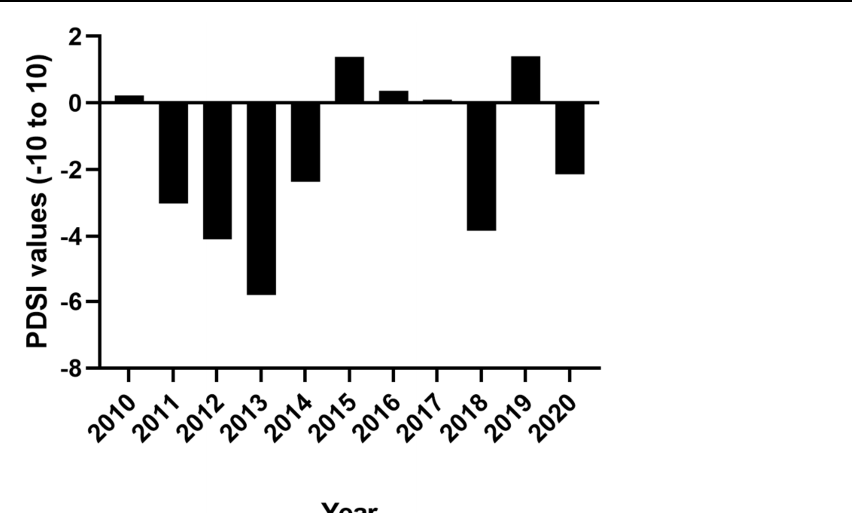
Figure 2. Averages from December 2009 through August 2020 for New Mexico climate division region 2 Palmer Drought Severity Index (PDSI); negative values indicate drier conditions and positive values indicate wetter conditions.